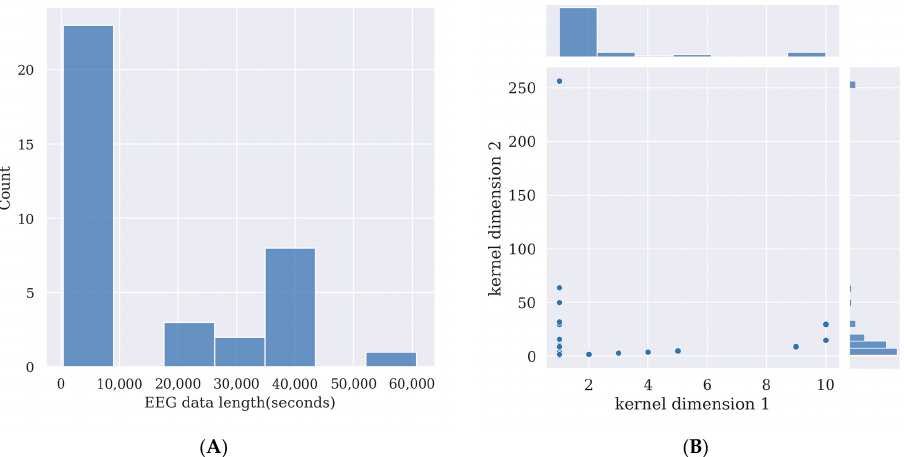
Figure 2. ( A ) A summary of steady-state visual evoked potential (SSVEP) data length per channel used by 31 deep learning studies, as shown in Table 2. ( B ) A summary of the kernel dimensions of convolutional layers in 31 deep learning studies, as shown in Table 2.